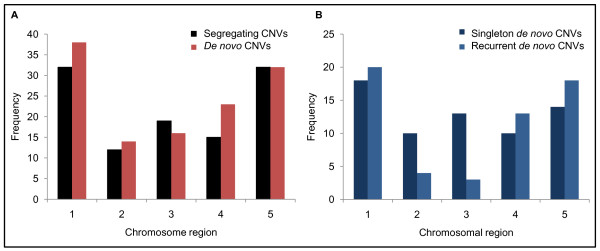
Chromosomal location of CNVs. All CNVs detected were placed into 5 chromosomal regions to identify the propensity for localization of CNVs in specific regions of the chromosome. (A) The segregating CNVs were predominantly located in the telomeric/subtelomeric regions. (B) Among the de novo CNVs, the singleton CNVs showed a chromosome wide distribution, compared to the telomeric/subtelomeric distribution of recurrent de novo CNVs.